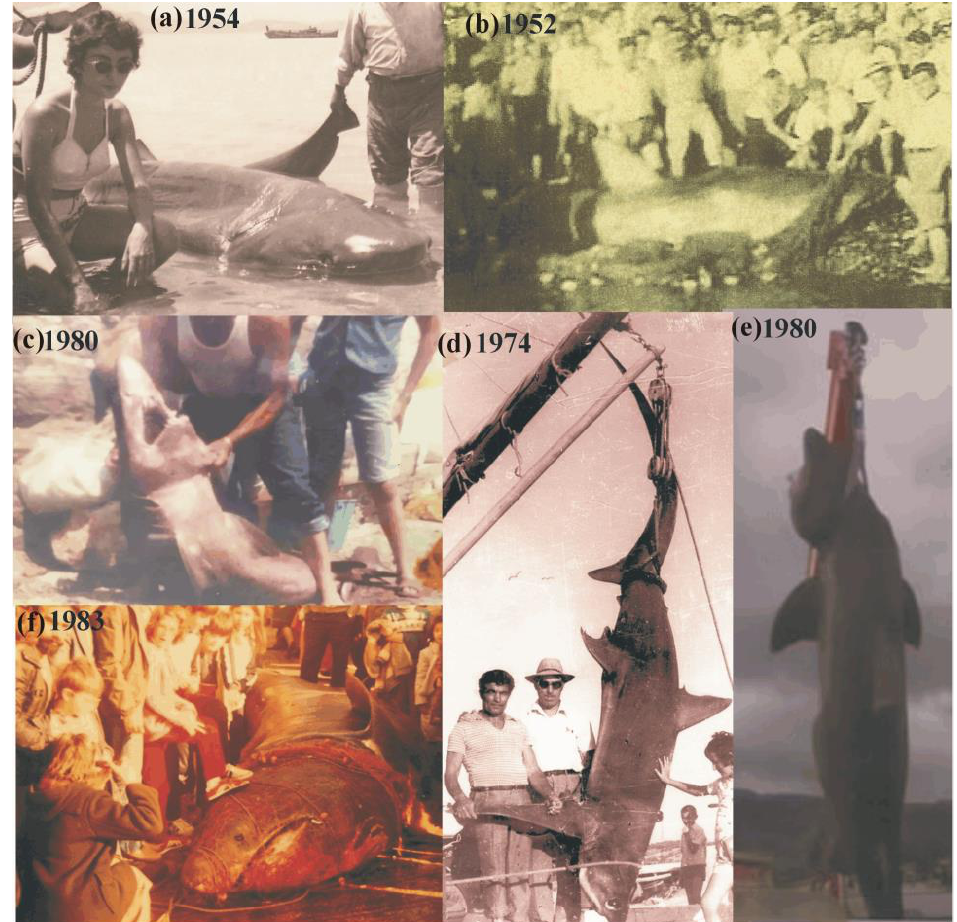
Figure 3. References on presence of sharks during the early fisheries period of the Greek fisheries: ( a ) Hexanchus griseus caught in Evvoikos gulf, ( b ) Carcharodon carcharias caught in North Aegean Sea, ( c ) Odontaspis ferox caught in Eastern Aegean Sea, ( d ) Alopias superciliosus caught in Argolikos gulf, (e) Cetorhinus maximus caught in Central Aegean Sea, ( f ) Cetorhinus maximus caught in North Aegean Sea.